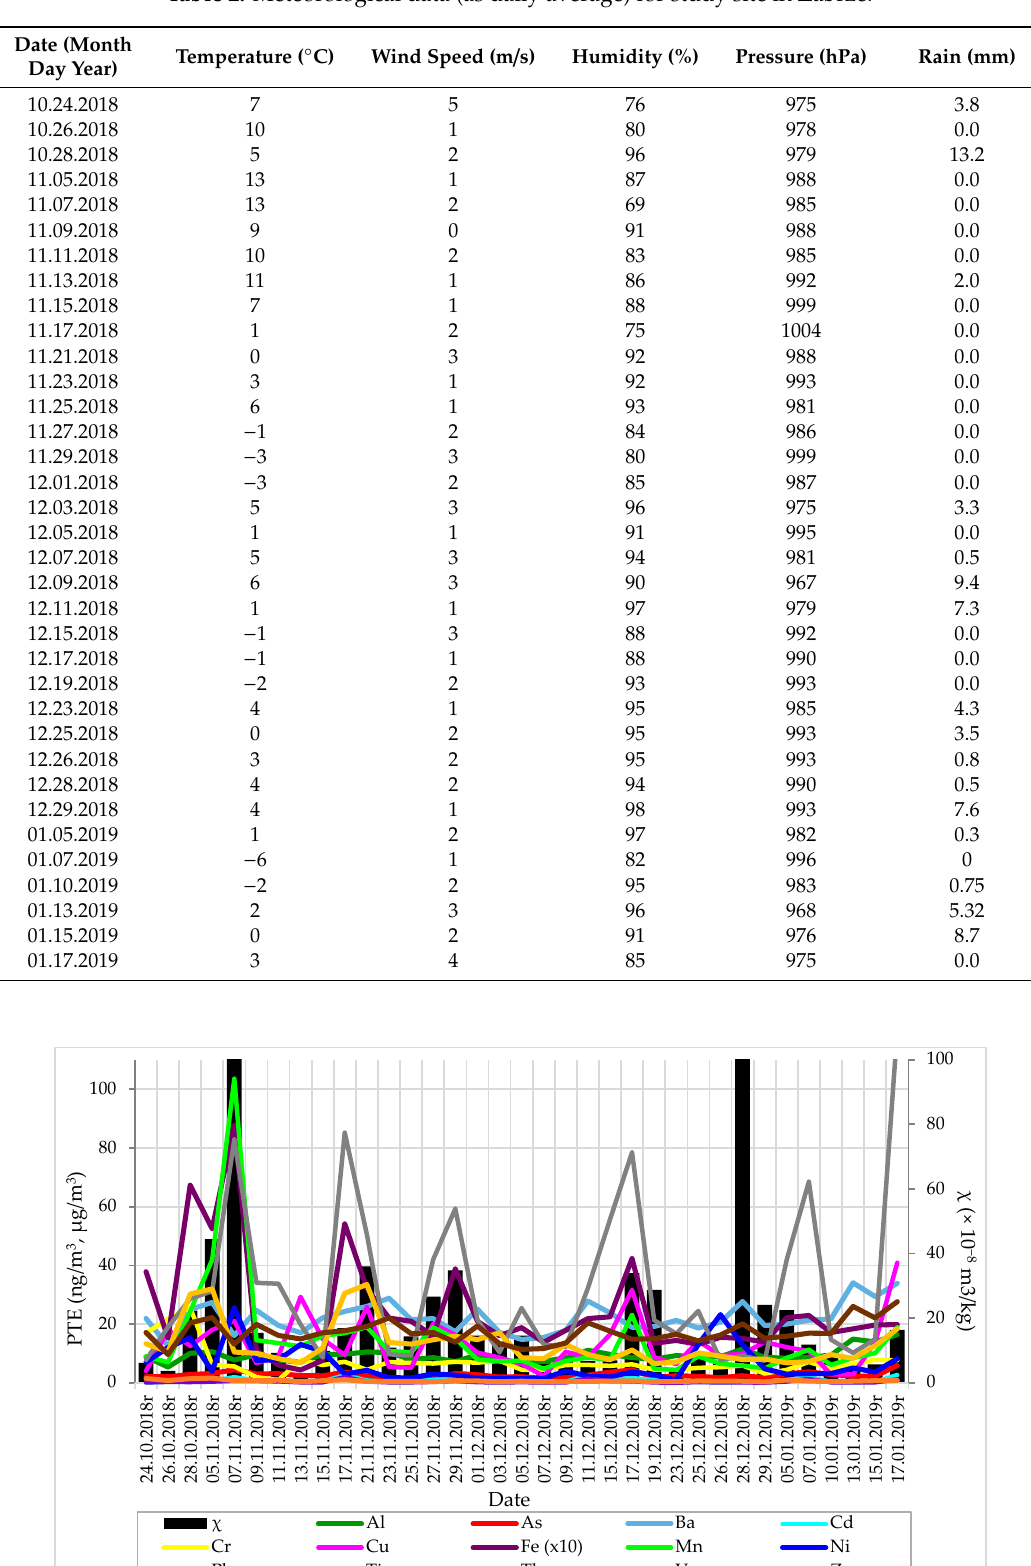
Figure 4. Mass-specific magnetic susceptibility ( χ ) and concentration of PTE ((As, Cd, Cr, Cu, Fe [×10], Mn, Ni, Pb, Ti, Tl and V in ng/m 3 ) and (Al, Ba and Zn in µg/m 3 )) in PM1 daily filters. Table 3. Descriptive statistics of magnetic susceptibility ( χ ) and concentration of PM (PM) and potentially toxic elements (n TSP = 35; n PM1 = 35). Element